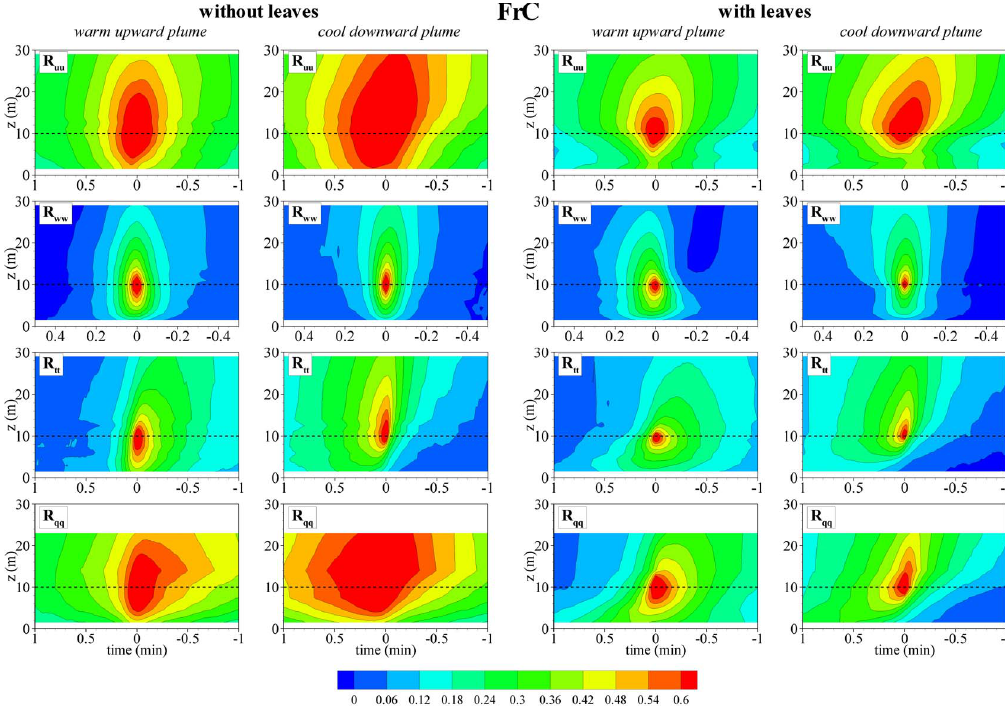
Fig. 7. Same as Fig. 6 but for autocorrelations referenced to canopy top ( Z = 10m).